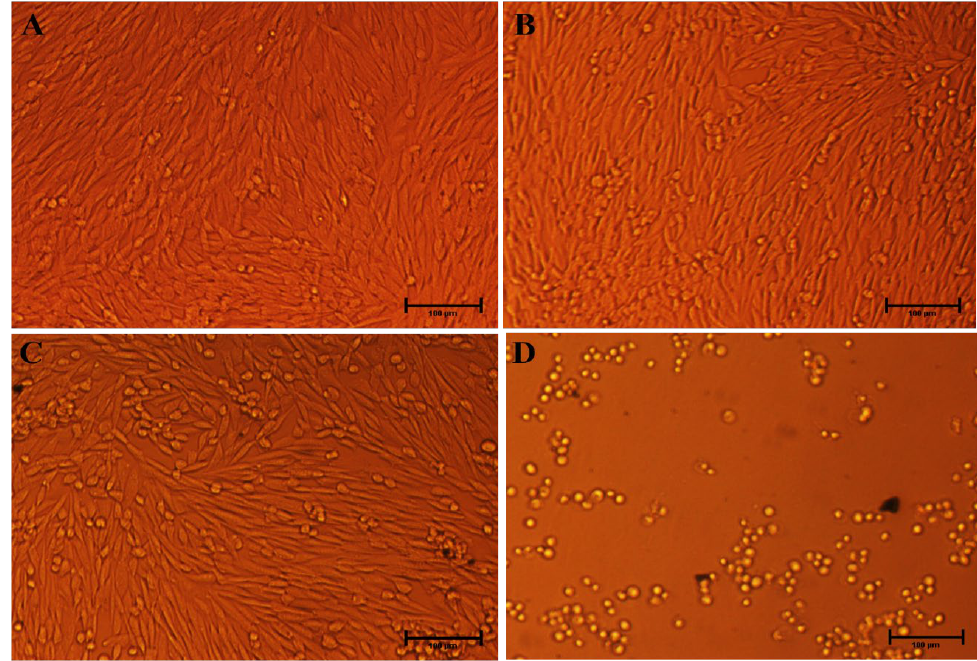
Figure 10. The morphological representation of the HCT-116 cells treated with different concentration of Ag-C-1. ( A ) Control HCT-116 cells; ( B – D ) treated with 5, 10 and 20 μg/mL. Scale bar 100 μm.